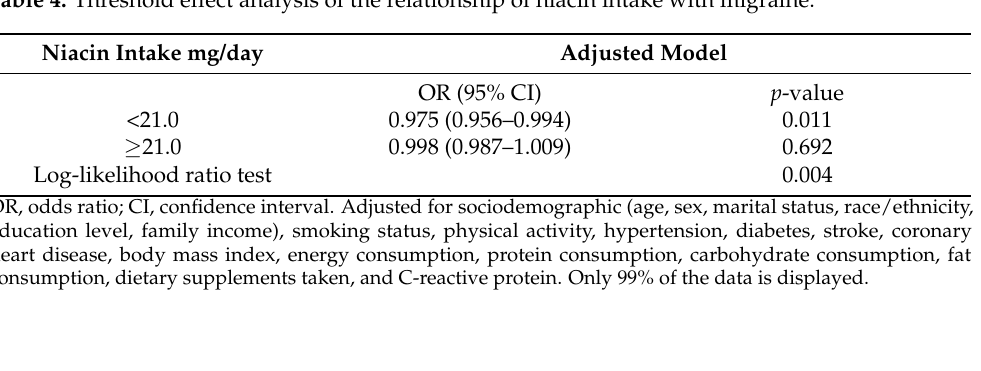
Figure 2. Association between dietary niacin intake and migraine odds ratio. Solid and dashed lines represent the predicted value and 95% confidence intervals. They were adjusted for age, sex, marital status, race/ethnicity, education level, family income, smoking status, physical activity, hypertension, diabetes, stroke, coronary heart disease, body mass index, energy consumption, protein consumption, carbohydrate consumption, fat consumption, dietary supplements taken, and C-reactive protein. Only 99% of the data is shown. Table 4. Threshold effect analysis of the relationship of niacin intake with